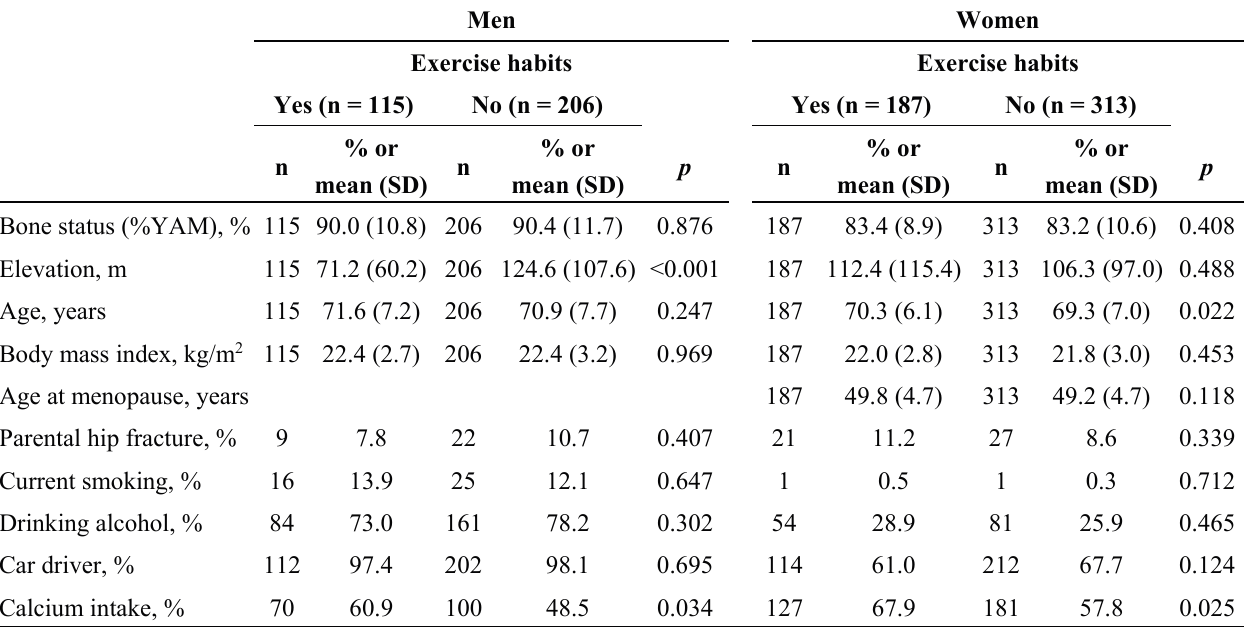
Table 1. Characteristics of the study